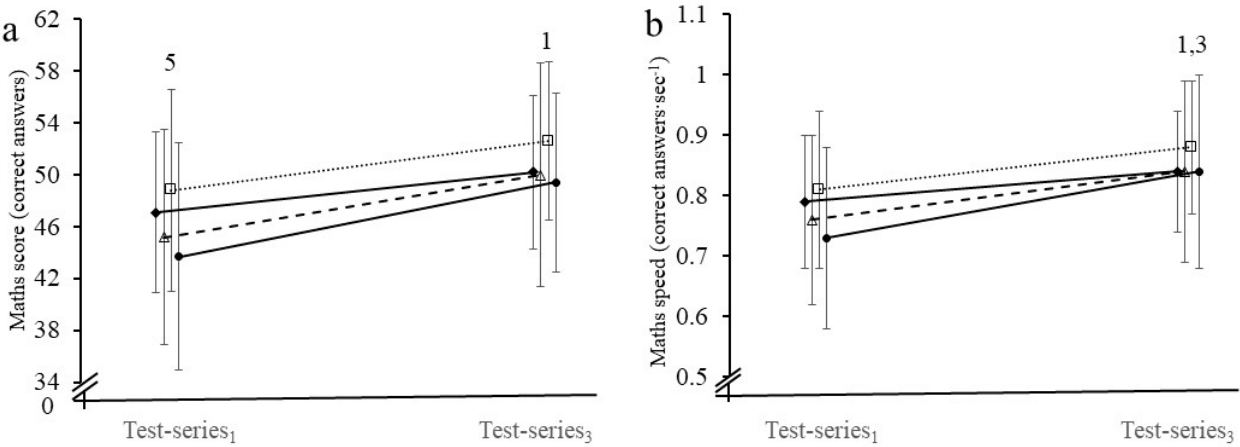
Figure 3. ( a ) Number of correct answers (mathematics score) and ( b ) correct answers per second (mathematics speed) in the fasted and sedentary (F-S, ♦ ), breakfast and sedentary (B-S, ∆ ), fasted and exercise (F-E, □ ), and breakfast and exercise (B-E, ● ) groups in the 60 s arithmetic test during test-series 1 and test-series 3 . 1 Change in B-E > than F-S over the test-series, p < 0.05. 3 Change in B-E > than F-E over the test-series, p < 0.05. 5 B-E different from F-E at test-series 1 , p < 0.05. Please note that there is no time lag in measurement among trials. Error bar: SD.